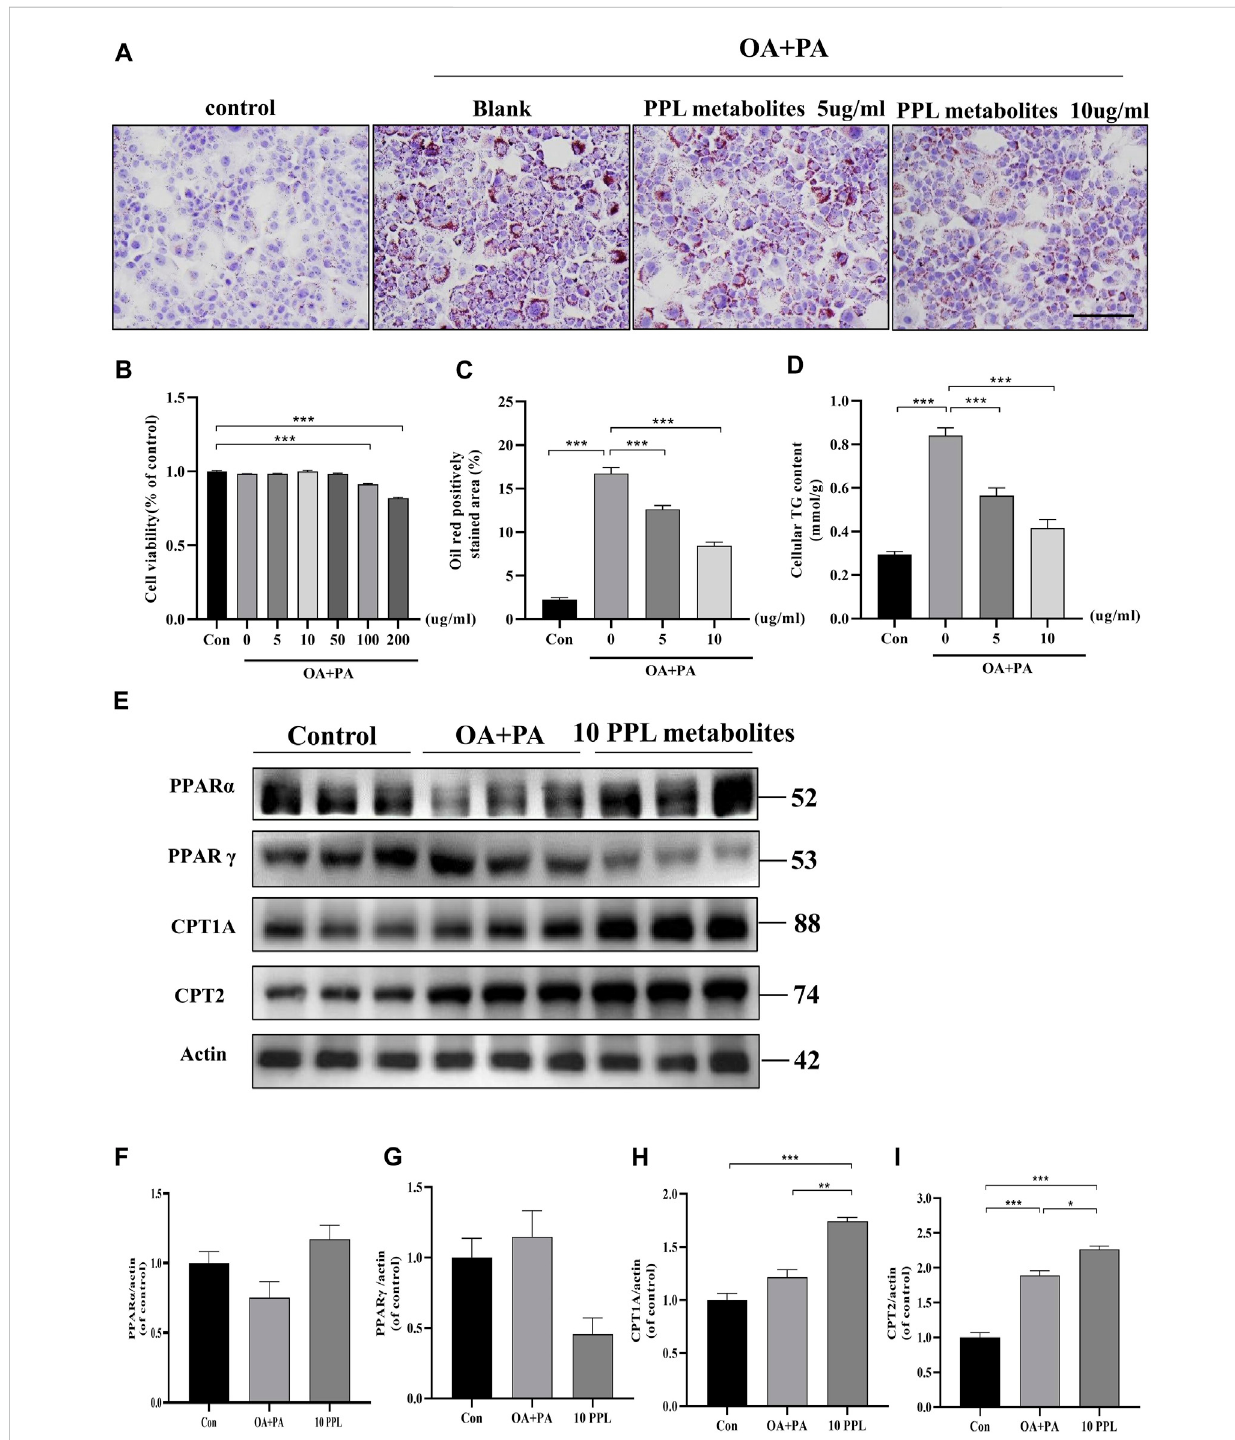
FIGURE 5 The lipid-lowering effect of PPL metabolites in PA/OA-treated AML12 cell line. (A) Oil Red O staining of PA/OA-induced lipid accumulation in AML12 cell line after treating with PPL metabolites. (B) Cell viability was detected by CCK8 after AML12 cells incubated with PPL metabolites and treated with PA/OA for 24 h (n = 9 per group). (C) Oil red O positively stained area was shown from each group (n = 7 per group). (D) Amount of cellular TG was detected from different group after above treatment (n = 4 per group). (E) The expression level of proteins PPAR α , PPAR γ , CPT1A and CPT2 in the AML12 cells were analyzed by immunoblotting (n = 3 per group). (F – I) The quantitative densitometric analysis of PPAR α , PPAR γ , CPT1A and CPT2. Magni fi cation: ×200, scale bar: 100 μ m. Data were expressed as the mean ± SEM. Differences among groups were compared by one-way ANOVA. * p < 0.05, ** p < 0.01, *** p <